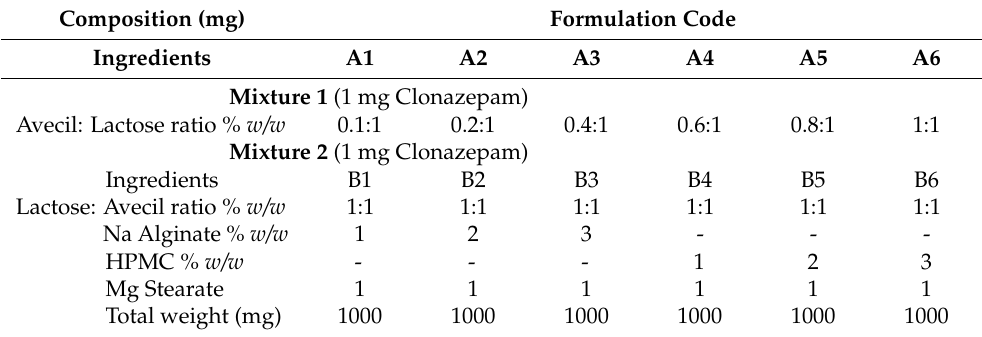
Table 2. Formulation of different batches of bilayer tablets of Clonazepam for optimization. Composition